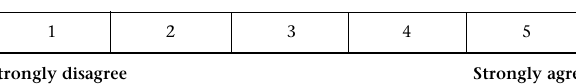
Figure 3: Proposed Intensity Response